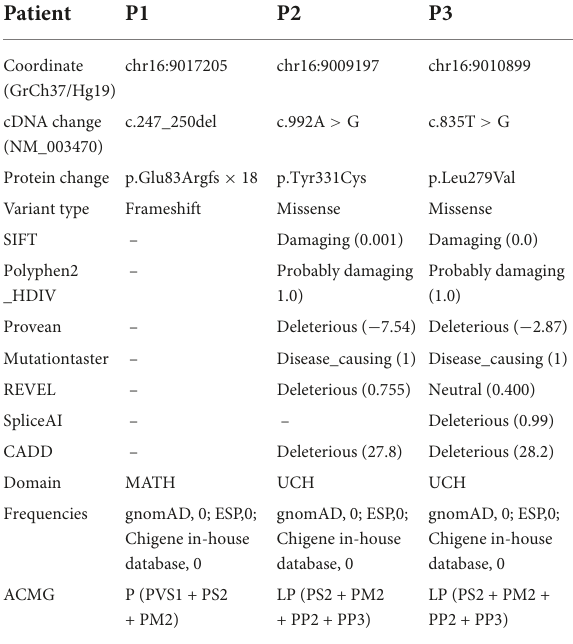
TABLE 3 The computer hazard predictions and ACMG pathogenicity rating of the three identified variants of USP7